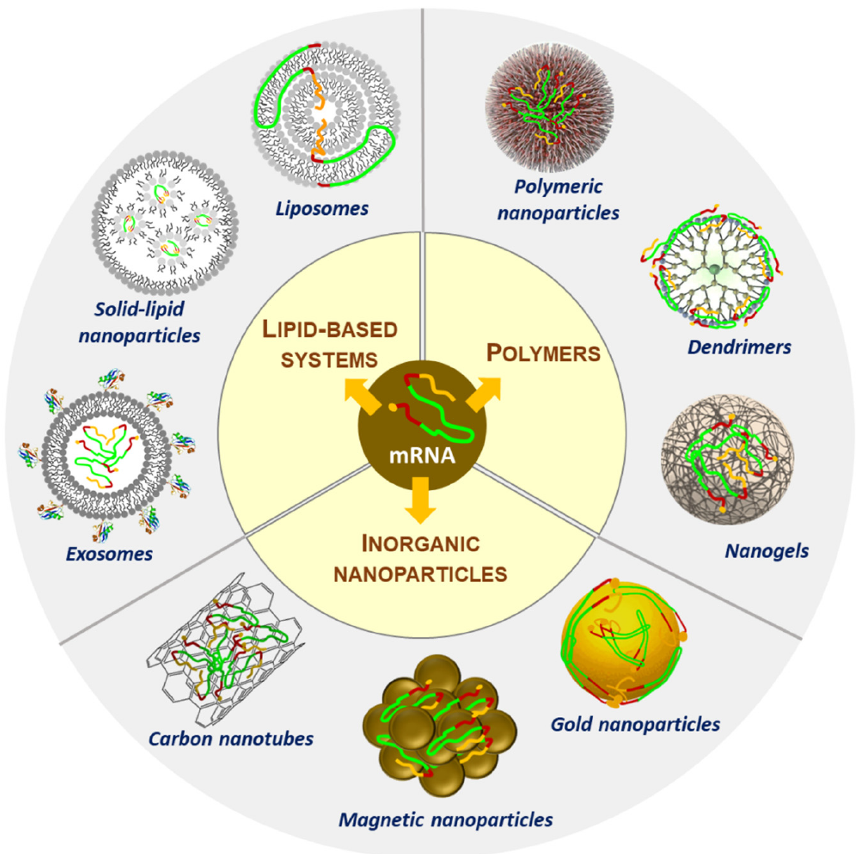
Figure 2 . Schematic representation of nanoparticles used in RNA delivery. Figure 2. Schematic representation of nanoparticles used in RNA